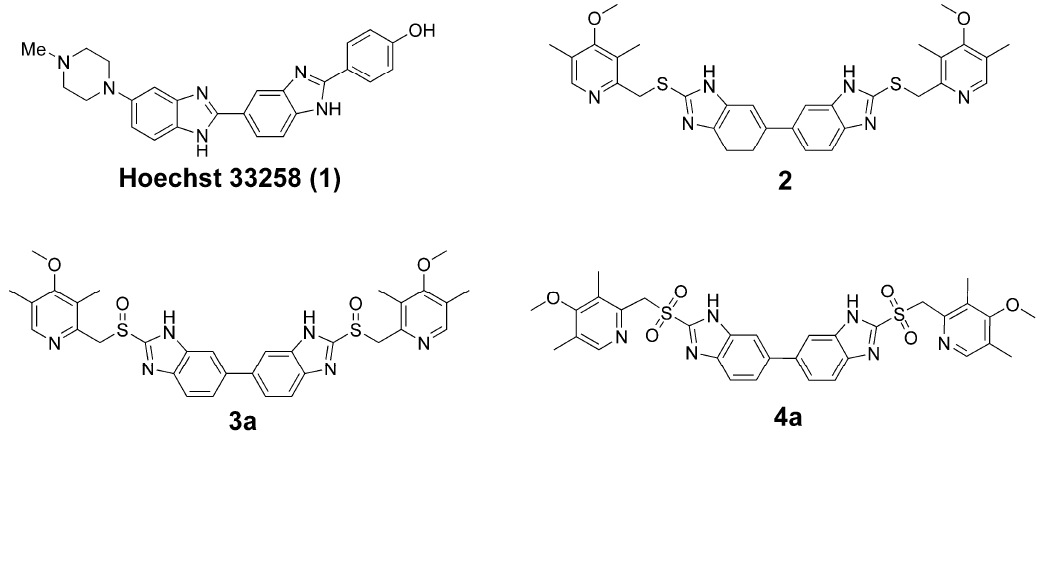
Figure 1 . Lead compounds 1 – 2 and designed compounds 3a , 4a